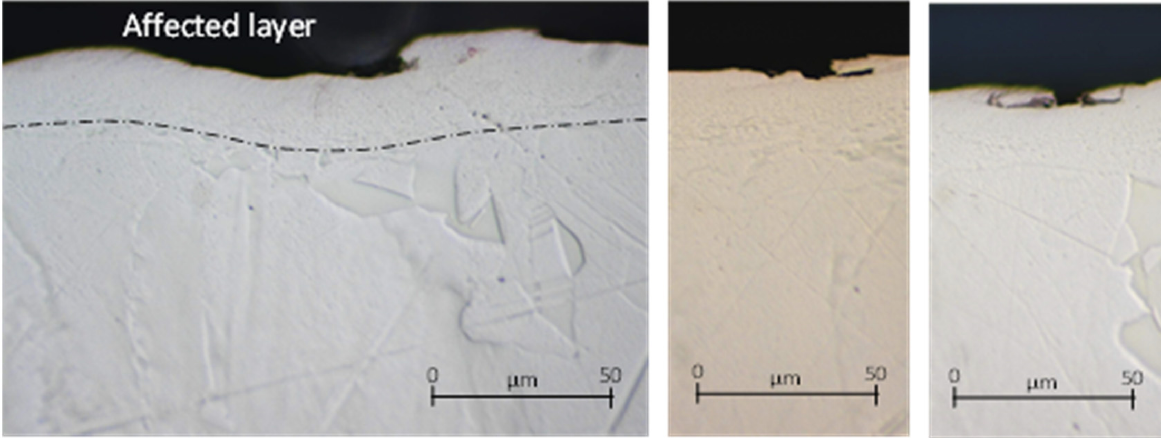
Figure 8. ( a ) SEM view of grease located in the tool tip. ( b ) Detail of Cu-Ni particles.